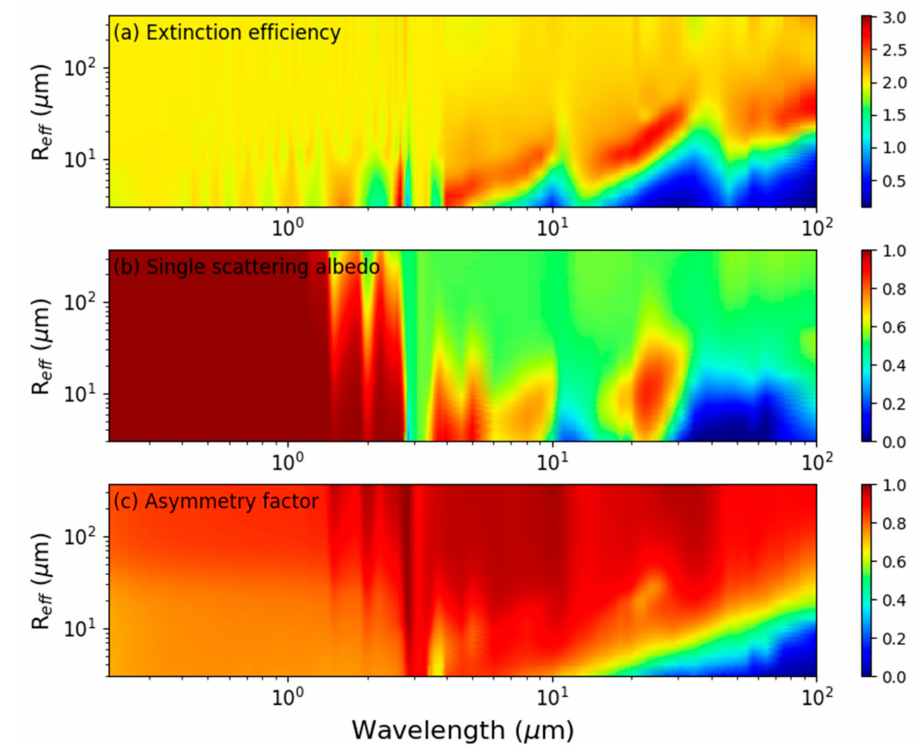
Figure 2. Contours of the ( a ) extinction efficiency, ( b ) single-scattering albedo, and ( c ) asymmetry factor of hexagonal ice particles as a function of effective radius and wavelength. The extinction efficiency is calculated using Equation (36).